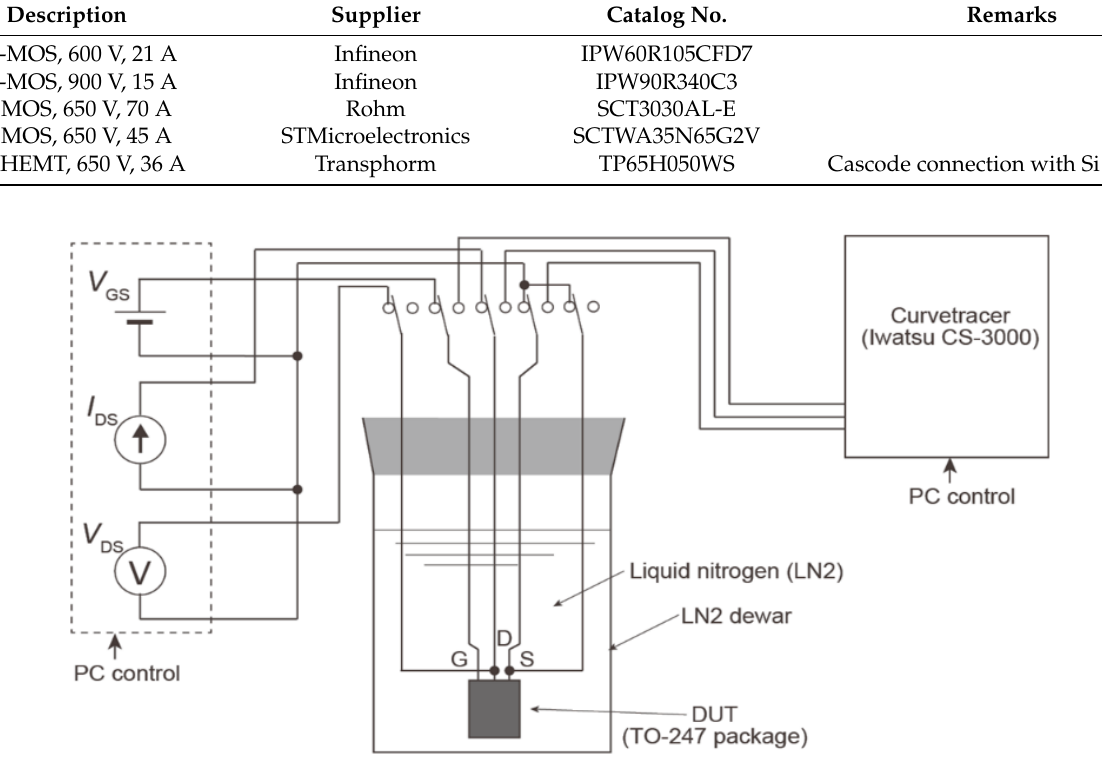
Table 2. Summary of the characteristics of power